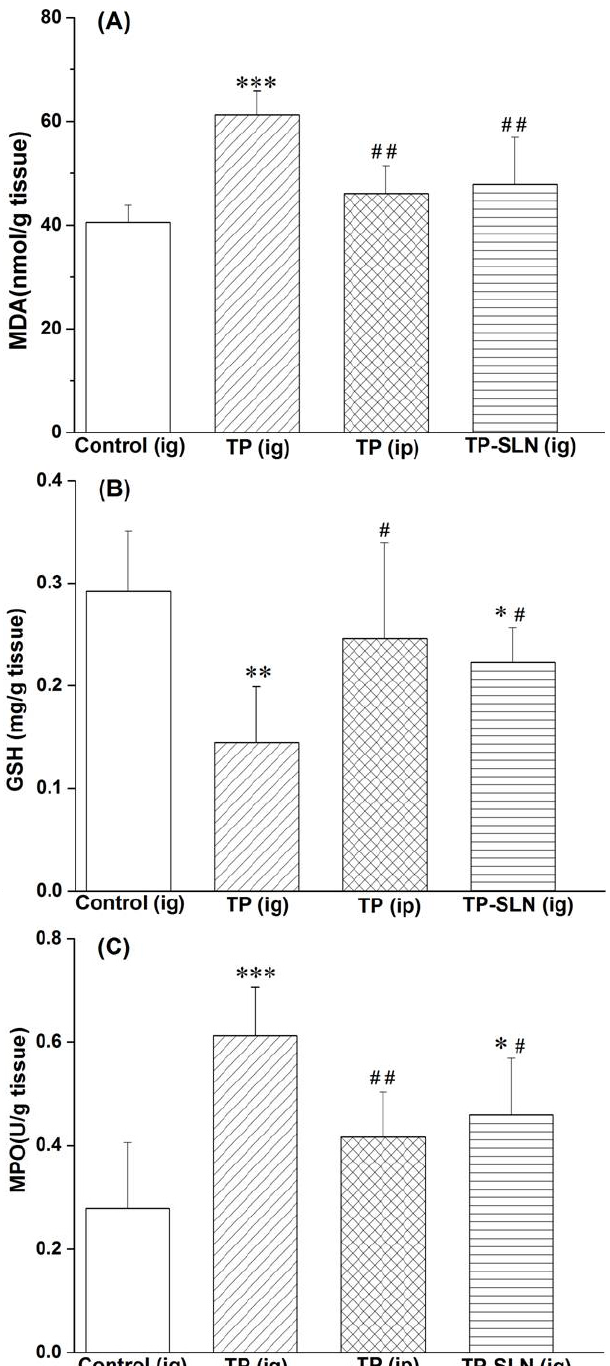
Figure 6. Levels of malonyldialdehyde (MDA) and glutathione (GSH), and activity of myeloperoxidase (MPO) in gastric mucosa after administration of TP and TP-SLN in rats. The results are expressed as mean ± SD (n = 6). * p < 0.05, ** p < 0.01, *** p < 0.001 compared with control group; # p < 0.05, ## p < 0.01 compared with TP (ig) group. Notes: ig, intragastric; ip, intraperitoneal